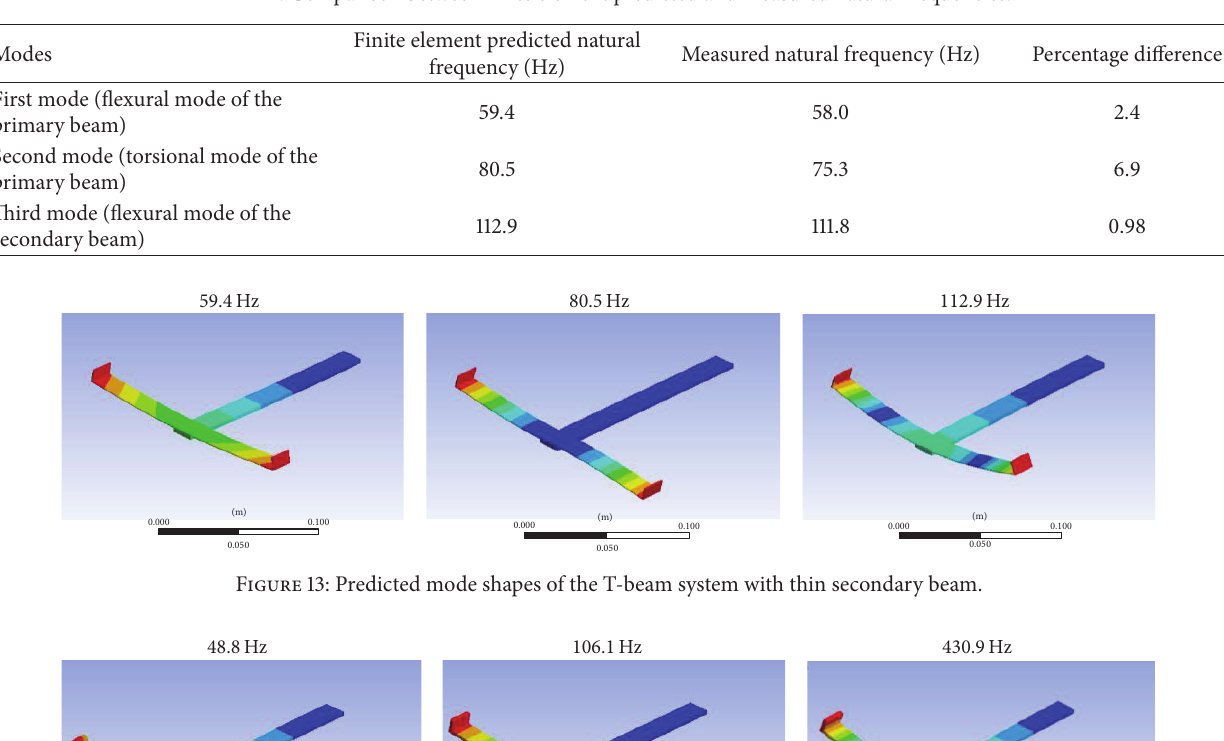
Table 2: Comparison between finite element predicted and measured natural frequencies.